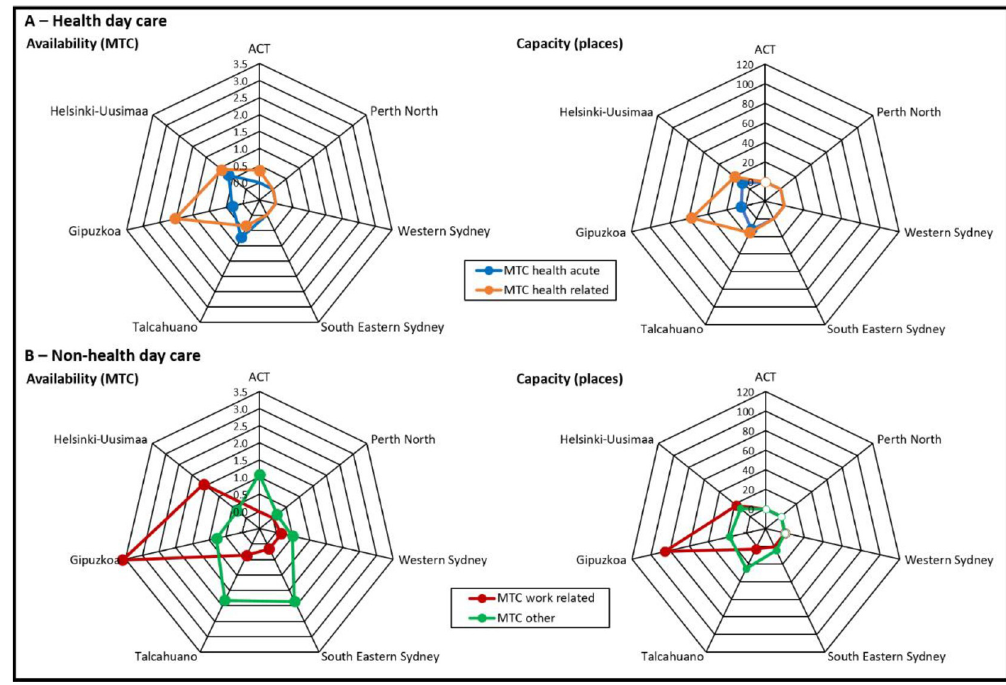
Fig 3. Availability of day care per 100,000 adults: Australian and international comparison. The axes of these graphs represent each of the study regions. Coloured lines representing the different types of day care join the points on each axis indicating the rate of that type of care per 100,000 adults for that